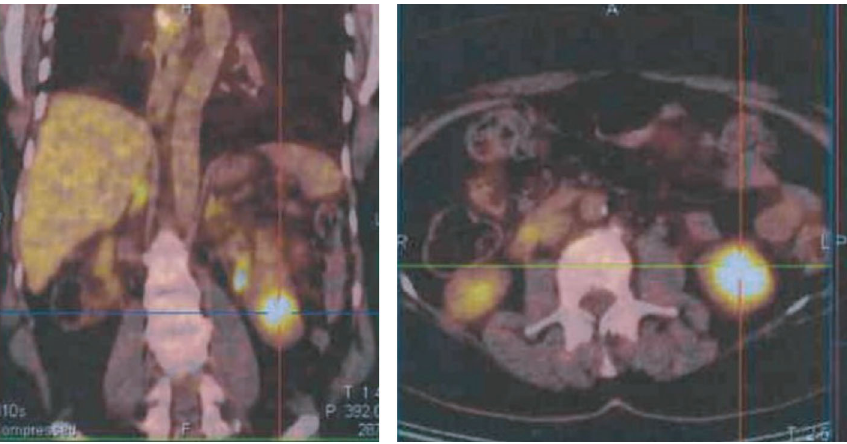
Figure 2: 18 F-Fluorodeoxyglucose positron emission tomography-computed tomography fusion scan images show a well-de fi ned, heterogeneously low-grade fl uorodeoxyglucose avid solid hypodense lesion at the lower pole of the left kidney.